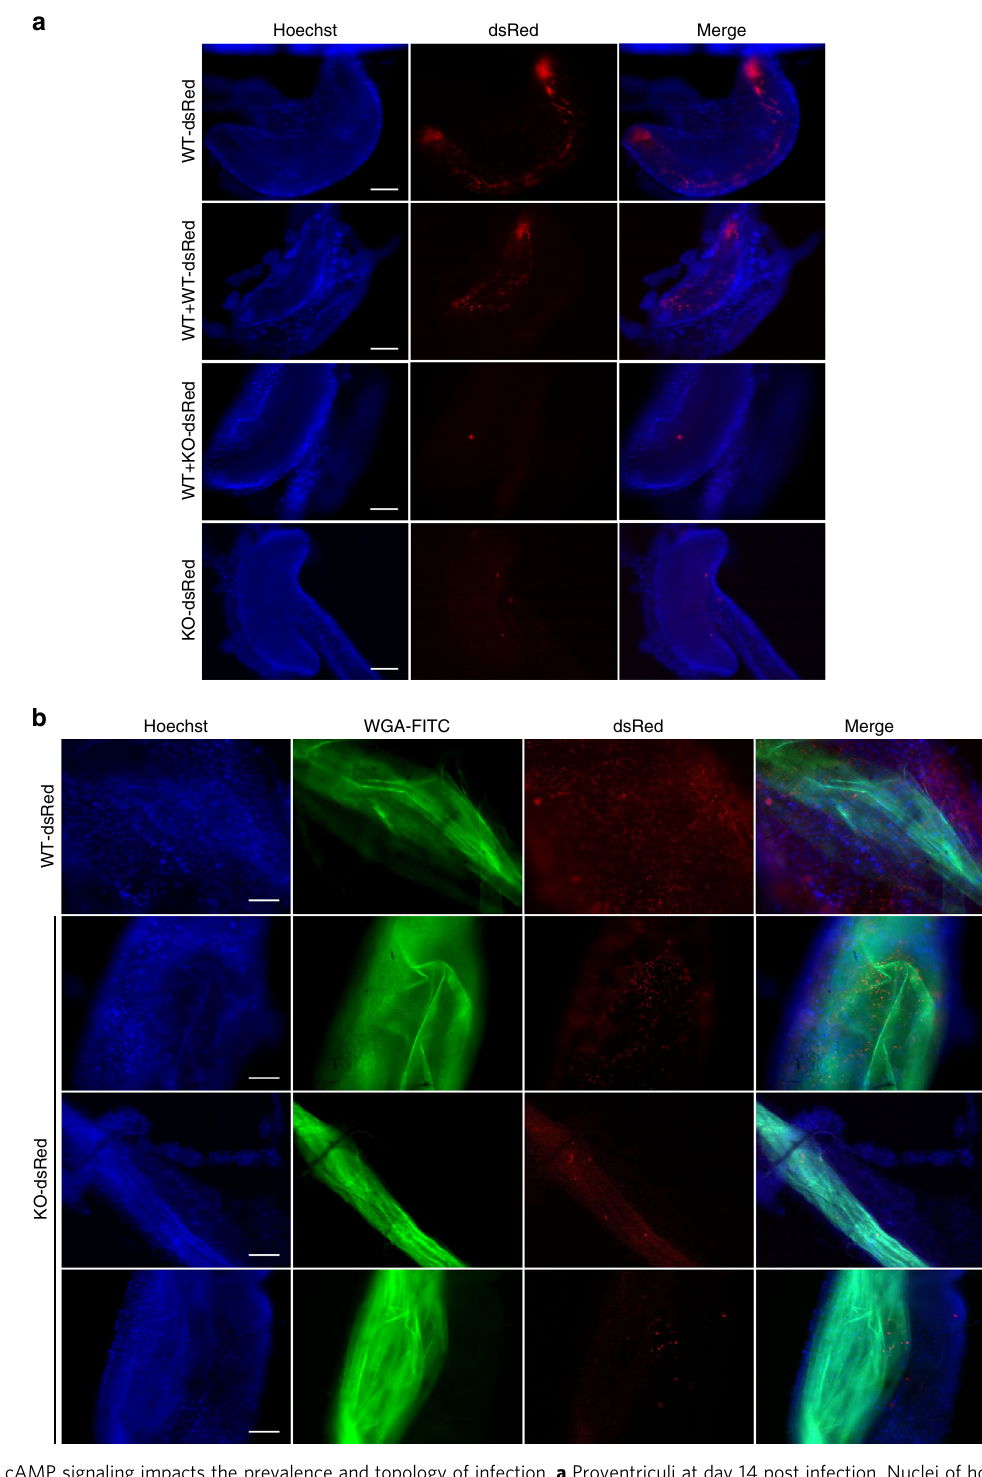
Fig. 7 Impaired cAMP signaling impacts the prevalence and topology of infection. a Proventriculi at day 14 post infection. Nuclei of host cells are stained with Hoechst dye. In mixed infections (middle panels), only the dsRed-tagged cells are visible. Supplementary Movie 4 shows merged DIC and red fl uorescent channels for a mixed infection with WT + KO-dsRed. b Midguts of fl ies infected with dsRed-tagged trypanosomes and fed with FITC-WGA 24 h prior to dissection at day 14. Nuclei of host cells are stained with Hoechst dye. Images in a and b were captured using a TillPhotonics/FEI iMIC digital spinning disc microscope. Scale bars: 100